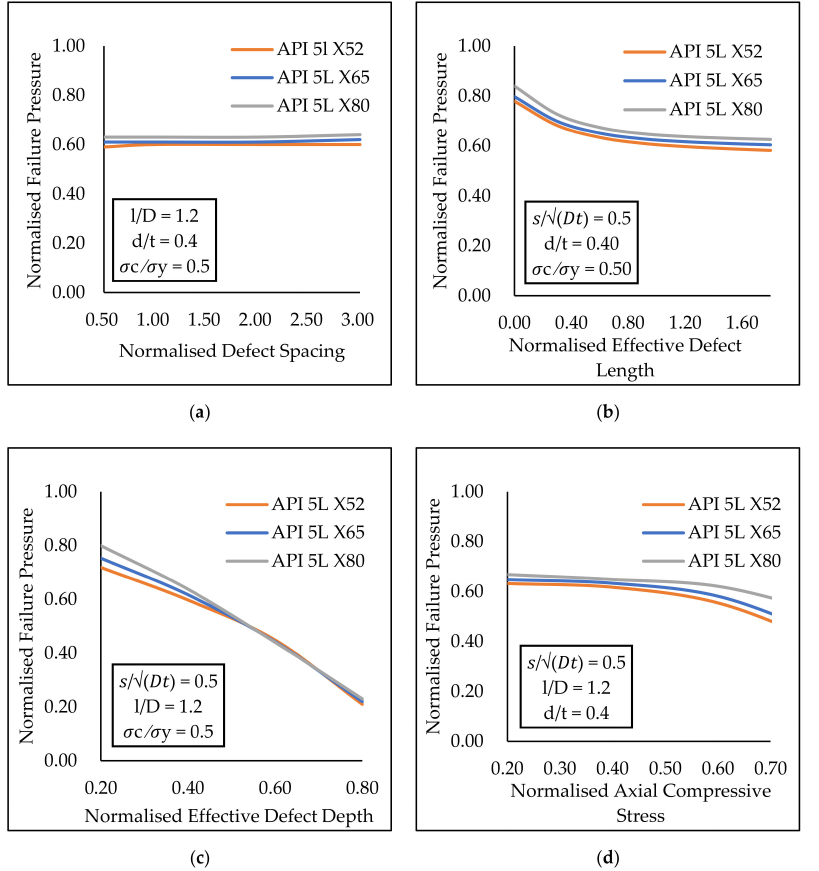
Figure 11. Failure pressure predictions for API 5L X52, X65, and X80 pipe for multiple normalized ( a ) defect spacing; ( b ) effective defect length; ( c ) effective defect depth; ( d ) axial compressive